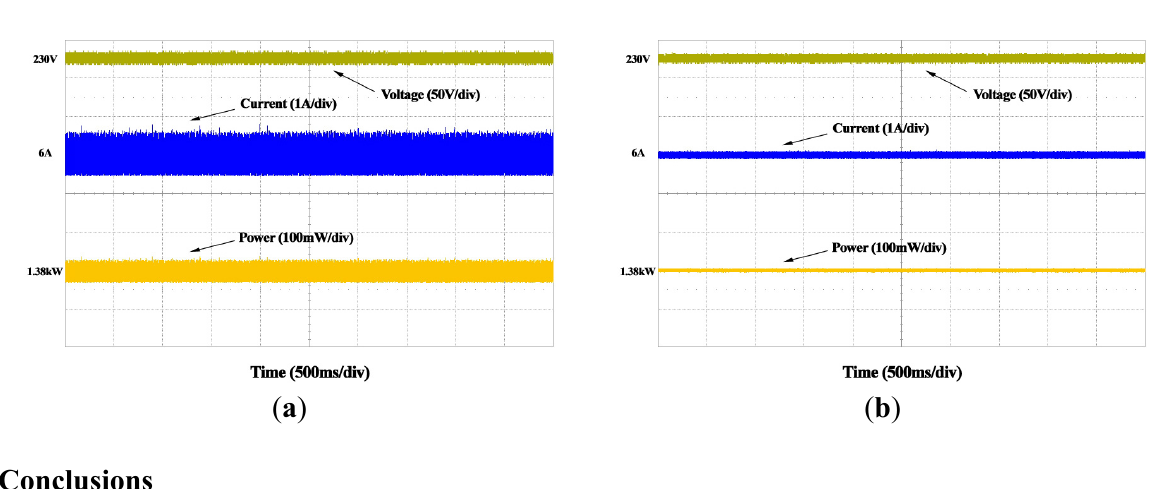
Figure 27. Magnitude of a PV voltage, current, and power. ( a ) Without compensation; ( b ) with